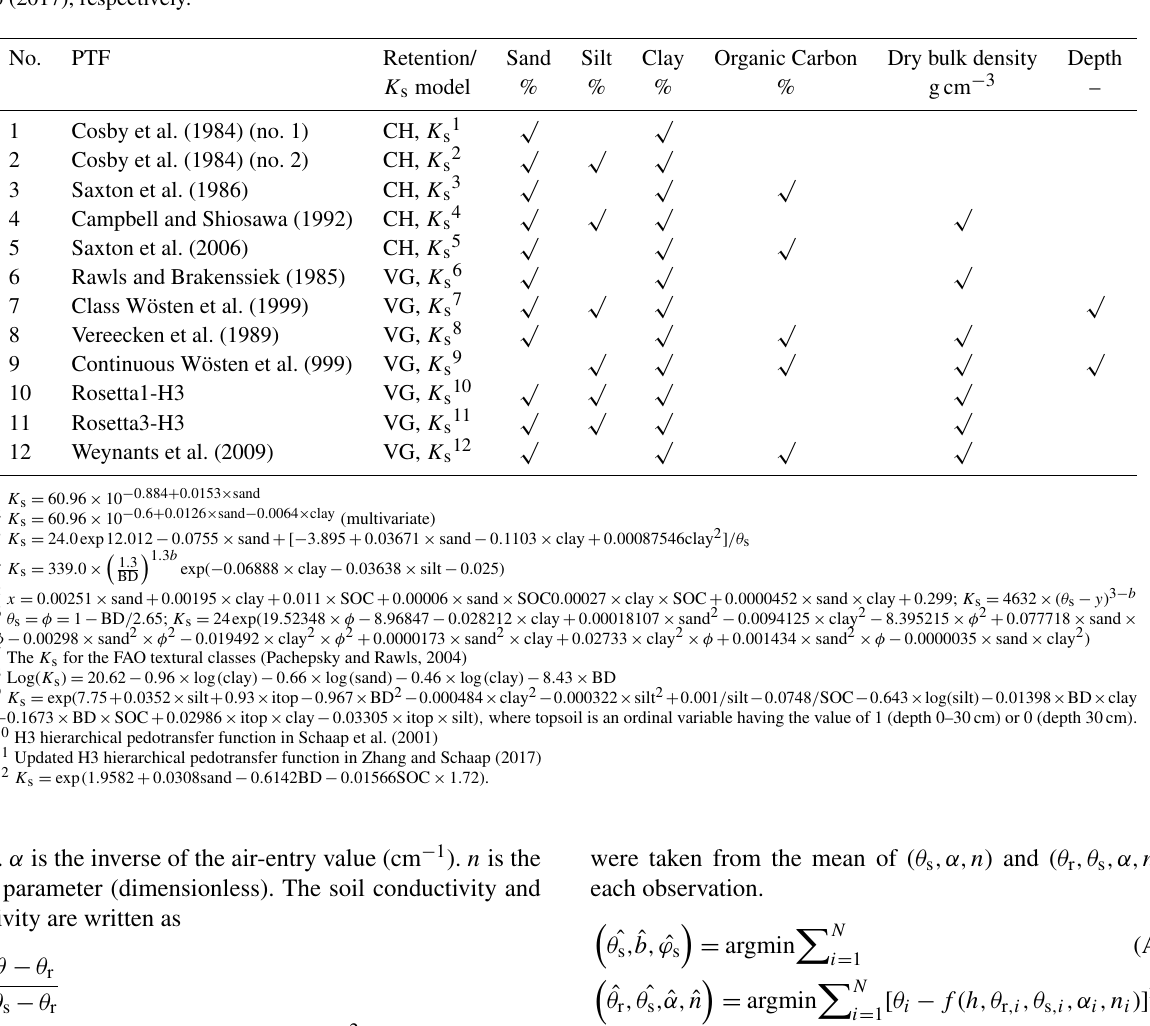
Table A1. List of PTFs for estimating the soil water retention curve, where 10 and 11 were cited by Schaap et al. (2001) and Zhang and Schaap (2017),